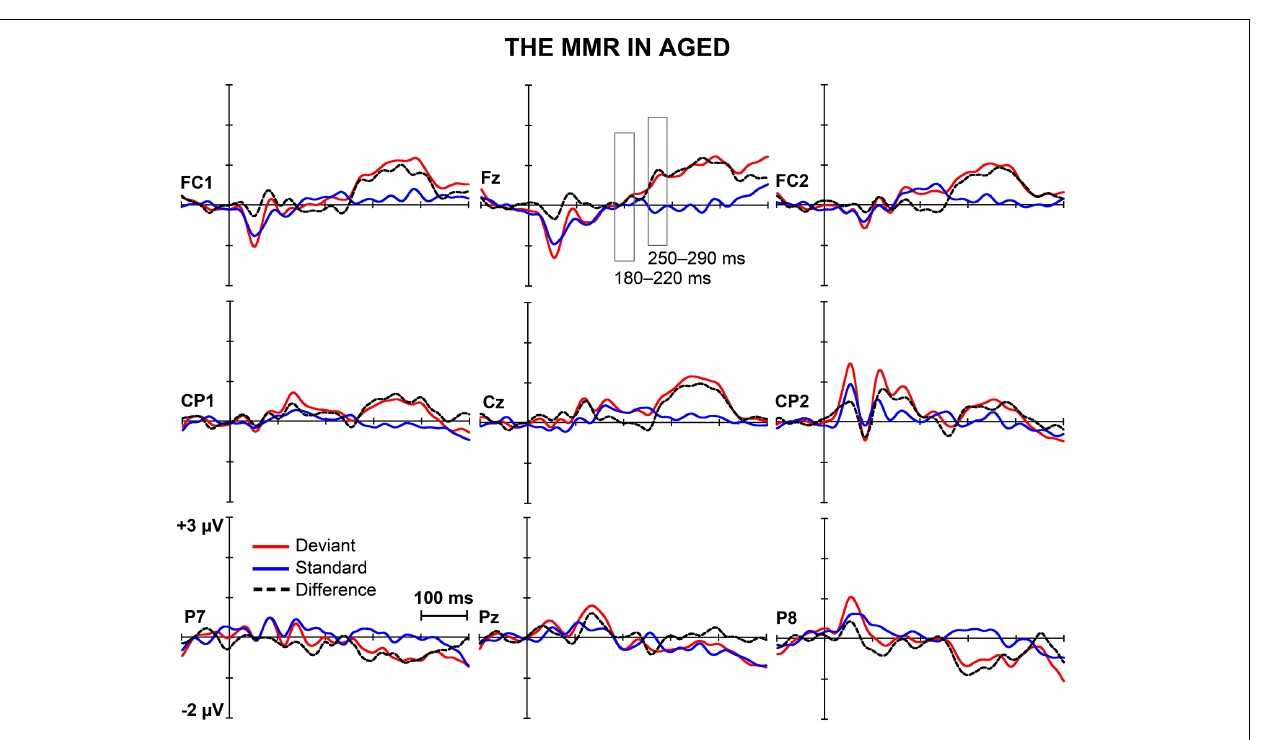
Frontiers inAging Neuroscience